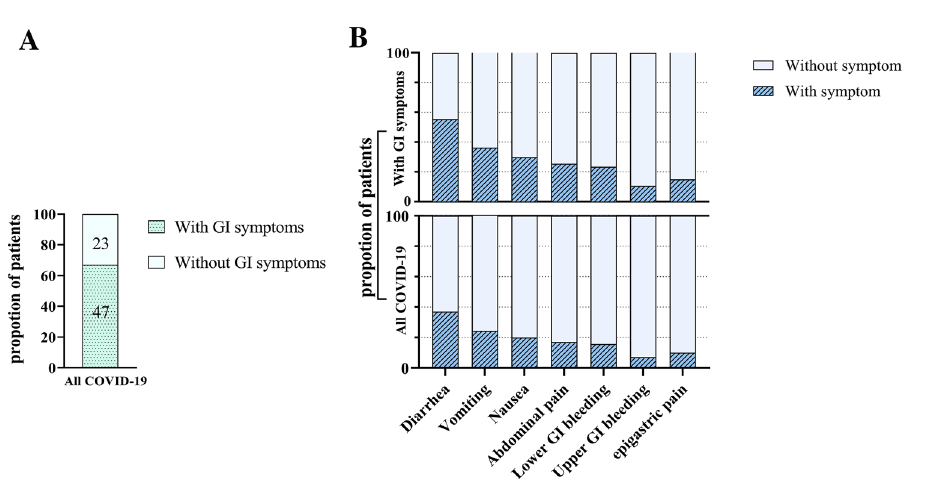
Figure 1. The proportion of patients based on GI symptoms. ( A ) The proportion of COVID-19 patients with or without GI symptoms. ( B ) Frequency of reported GI symptoms in both all patients and patients with GI